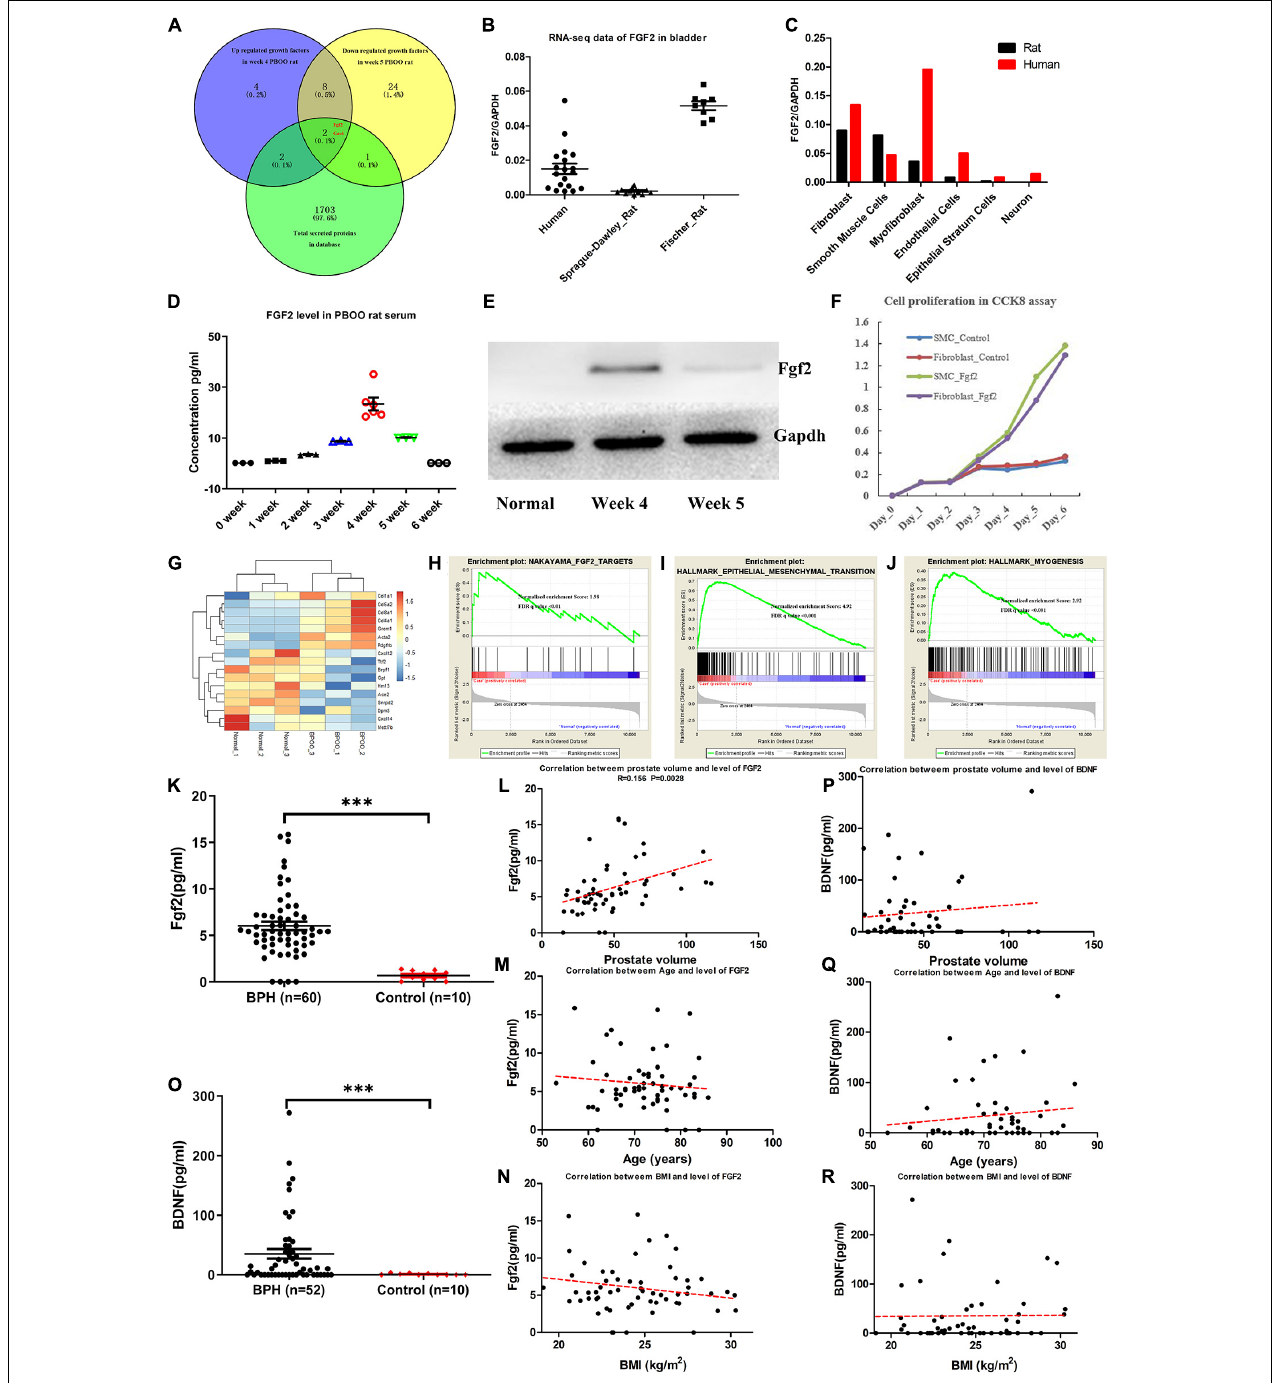
FIGURE 6 | Fgf2 expression in the development of PBOO and correlation with clinical data. Venny plot (A) show that Fgf2 and Gas6 were common among high expression in week 4, low expression in week 5 PBOO rat and characteristic for secreted protein. Fgf2 expressed in free-disease bladder tissues (B) . Fgf2 expressed in different cell types of bladder tissues (C) . The level of Fgf2 in rat serum ( n = 3, female) from 0 ∼ 6 weeks (D) . Western blot show Fgf2 expression in normal, week 4 and week 5 PBOO rat bladder tissues (E) . Fgf2 promote smooth muscle cell and fibroblasts proliferation in CCK8 assay (F) . Heatmap plot show 7 low and 10 high expression gene were distributed between PBOO and normal bladder tissues (G) . GSEA analysis show three major pathway changes in PBOO rat bladder tissues compared normal (H–J) . BPH patients exhibited higher expression levels of FGF2 (K) and BDNF (O) in the serum. Pearson correlation between the level of FGF2 in serum of BPH patients and prostate volume (L) , age (M) and BMI (N) . Pearson correlation between the level of BDNF in serum of BPH patients and prostate volume (P) , age (Q) , and BMI (R) . *** p < 0.001.